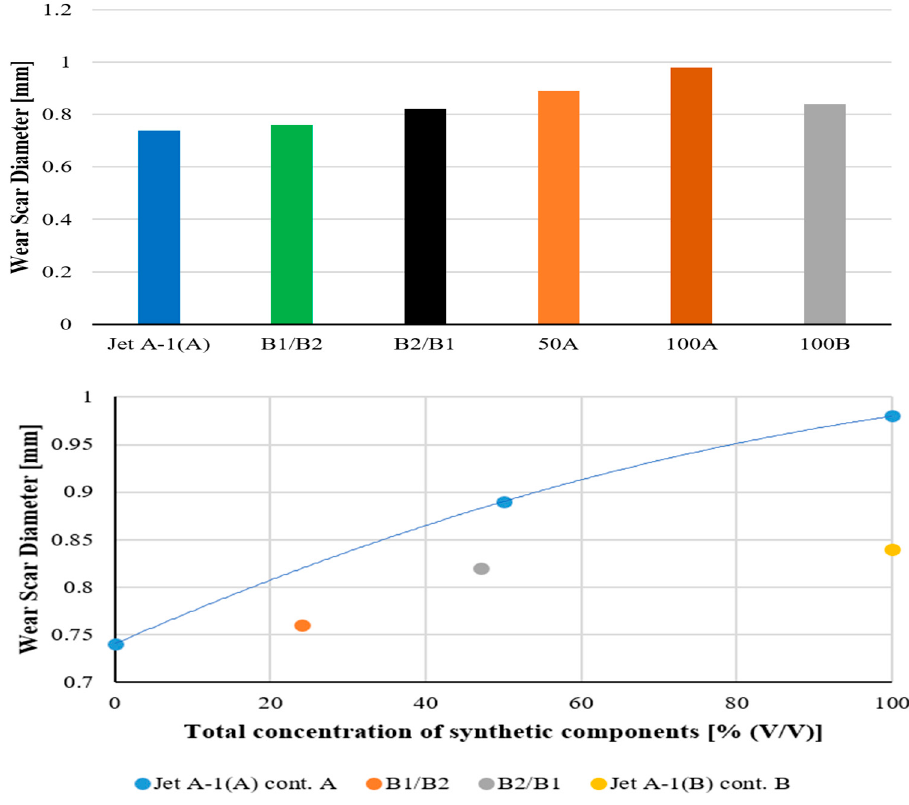
Figure 7. BOCLE method lubricity of the tested blends.